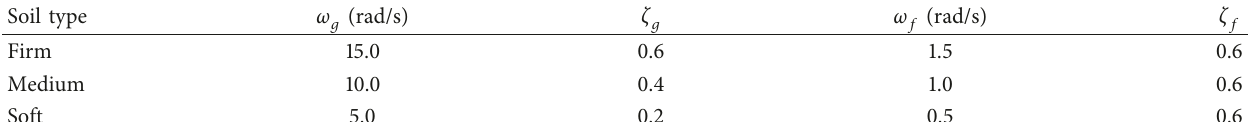
Table 1: Filter parameters depending on soil conditions (Der Kiureghian and Neuenhofer [37]).